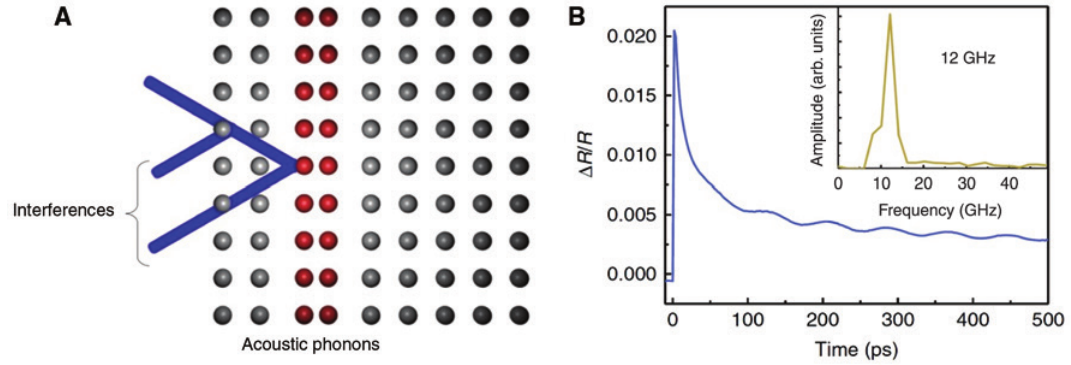
Figure 9: Coherent phonons detection. (A) Scheme representing the detection mechanism of coherent acoustic phonons using femtosecond light pulses. (B) Transient reflectivity signal obtained on CH NH PbI and revealing oscillations due to propagating coherent acoustic phonons. Inset: Fourier transform of these oscillations. 3 3 3 Adapted from [16].